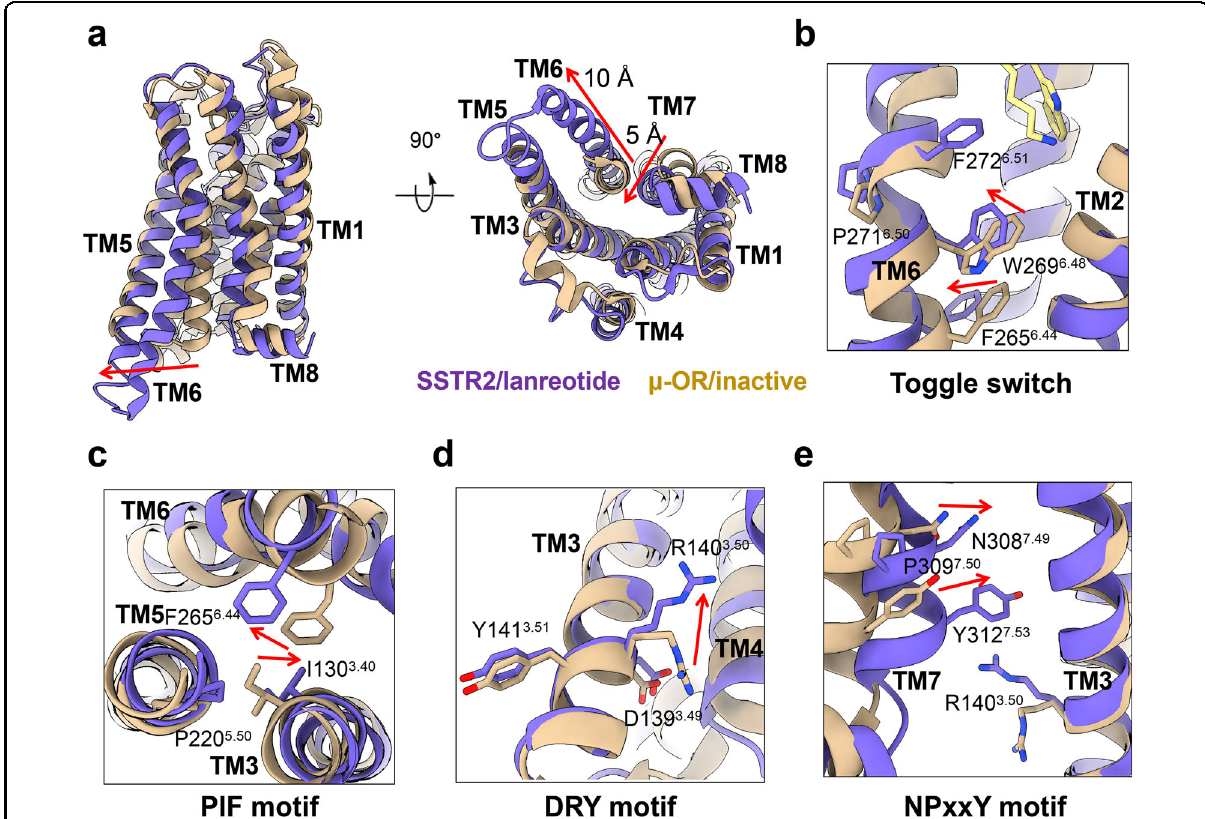
Fig. 3 Conformational change analysis of SSTR2 receptor upon binding of lanreotide. a Comparision of lanreotide-bound SSTR2 (purple) and inactive state μ -OR (tan). b – e Conformational changes of toggle switch ( b ), PIF motif ( c ), DRY motif ( d ) and NPxxY motif ( e ) after SSTR2 activation upon binding of